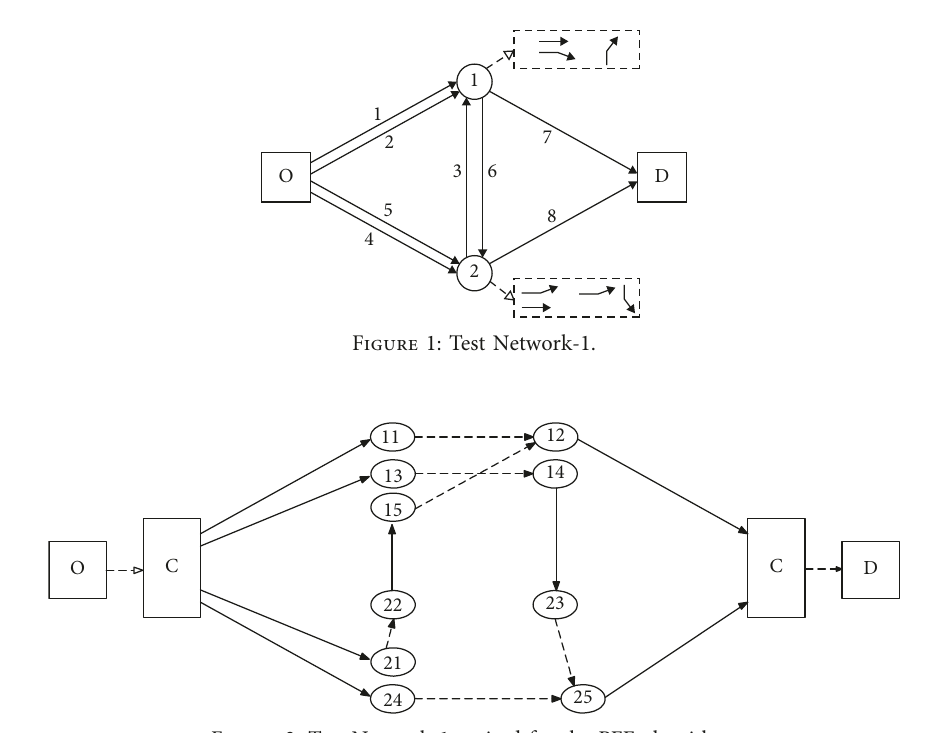
Figure 2: Test Network-1 revised for the PFE